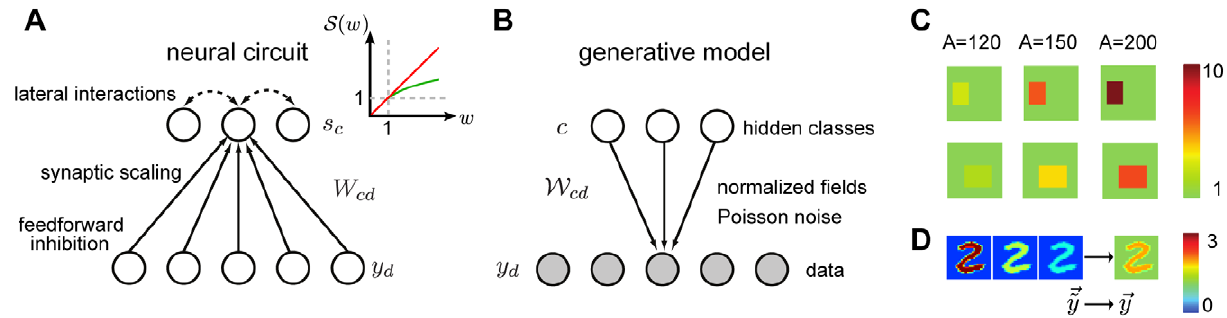
Figure 1. An overview of the model. (A) The neural circuit receives normalized inputs conveyed by excitatory synapses to a processing layer (large figure). The activity of the processing neurons is determined by the received inputs and internal dynamics mediated by lateral interactions. Inset: Two forms of weight scaling. The red curve shows conventional linear scaling, the green curve logarithmic scaling for values larger one. (B) Inputs to the circuit are modeled using a mixture model with normalized generative fields and Poisson noise. (C) Example normalized fields, with different values of the normalization constant A . (D) Illustration how inputs with different contrast levels are normalized (background set to 1).